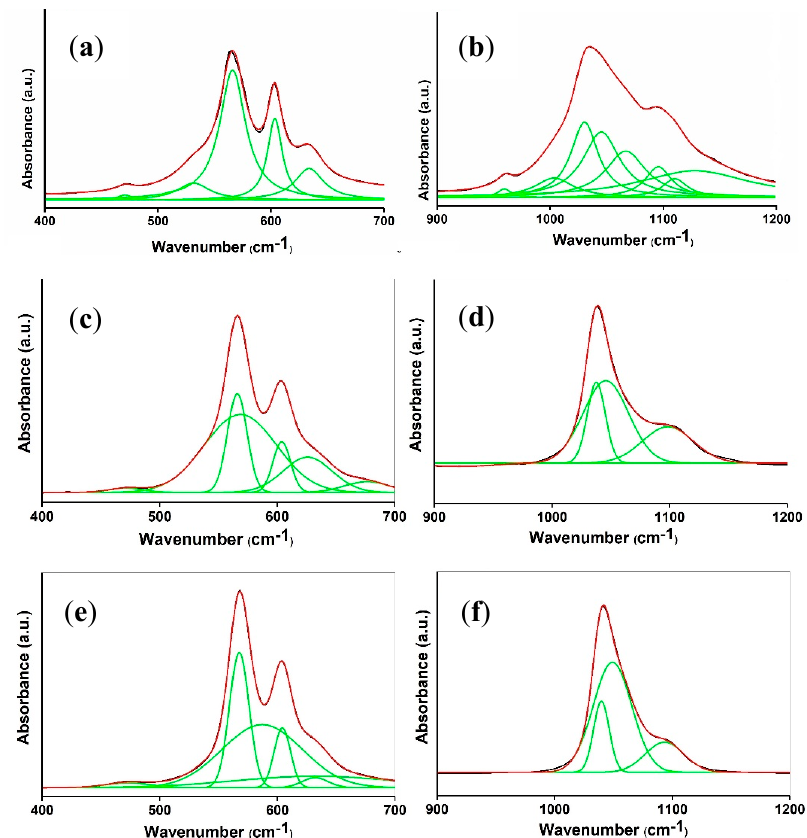
Figure 6. FTIR deconvoluted spectra in the 400–700 cm − 1 and 900–1200 cm − 1 spectral regions for HAp suspension ( a , b ) and 5SmHAp suspension ( c , d ) and coatings ( e , f ).